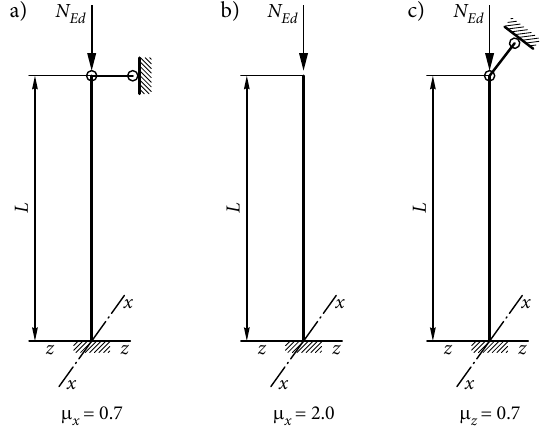
Fig. 2. End support conditions of the column: about axis x-x (a) and (b), about axis z-z Table 1. Column parameters Parameter Fig. 1. An axially compressed steel built-up column and ch.Ed.EC 3